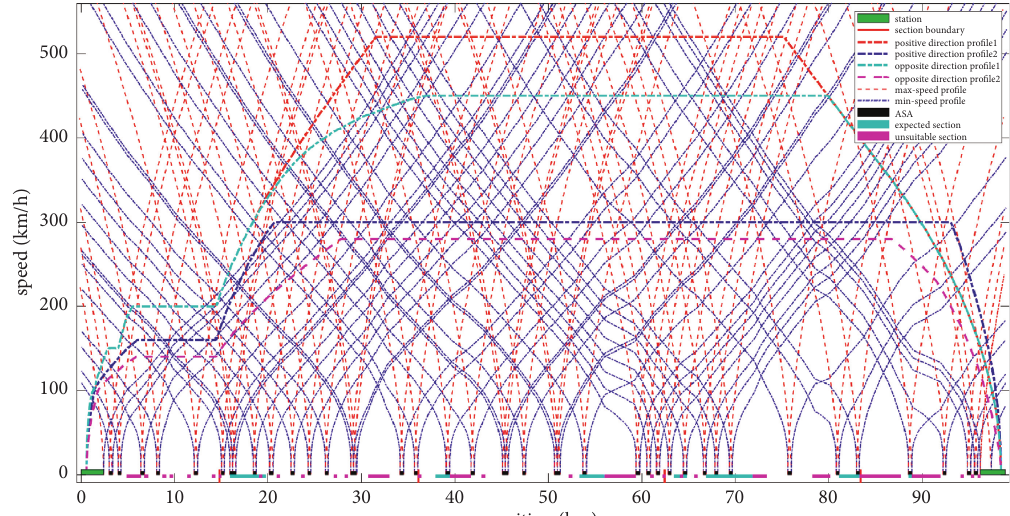
Figure 4: Result based on the uniform distribution (stepping redundancy time is 2s). Unsuitable areas are candidate auxiliary stopping areas that do not meet the constraint conditions as equations (5), (6), and (7). The positive direction profiles and the opposite direction profiles are the trains operating speed curves with different directions and reference speeds. The max-speed profile and the min-speed profile are the limitation speed curve of the corresponding auxiliary stopping area. area, and other constraint information are calculated, Step 3: evaluation of the plan. The information of in- respectively, and then the fitness value of each indi- dividuals in the population is decoded, and the original vidual is obtained according to the objective function objective function value and the minimum stopping with penalty items. point stepping time, the total length of the stopping